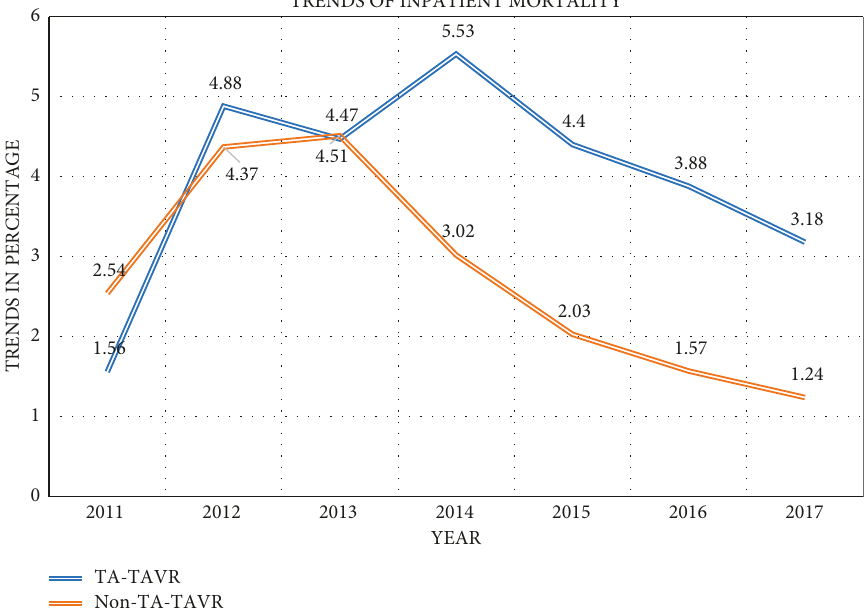
Figure 2: Trends of inpatient mortality from